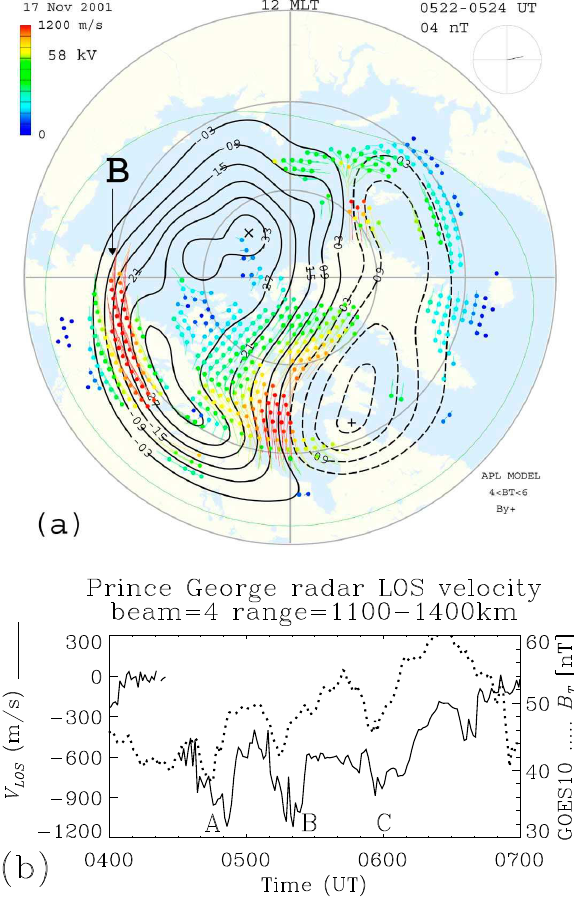
Fig. 5. ( a ) The convection/potential map showing an intense convection pulse B. ( b ) The Prince George radar line-of-sight velocity (solid line) and magnetic field magnitude (dotted line) at geosynchronous orbit.